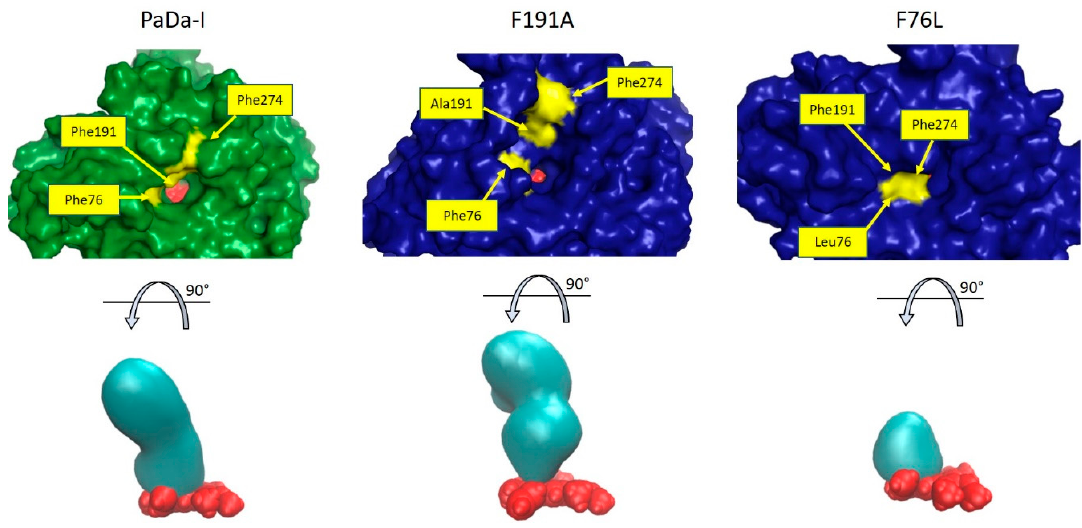
Figure 6. Upper view of the heme channel of the parental PaDa-I (green) and mutants F191A and F76L (blue), showing the changes in topography. The heme group is shown in red spheres and residues 76, 191, and 274 in yellow surface. In the lower part, the shape of the volume (in cyan) conforming the heme channel with respect to the heme group (red spheres) is shown.